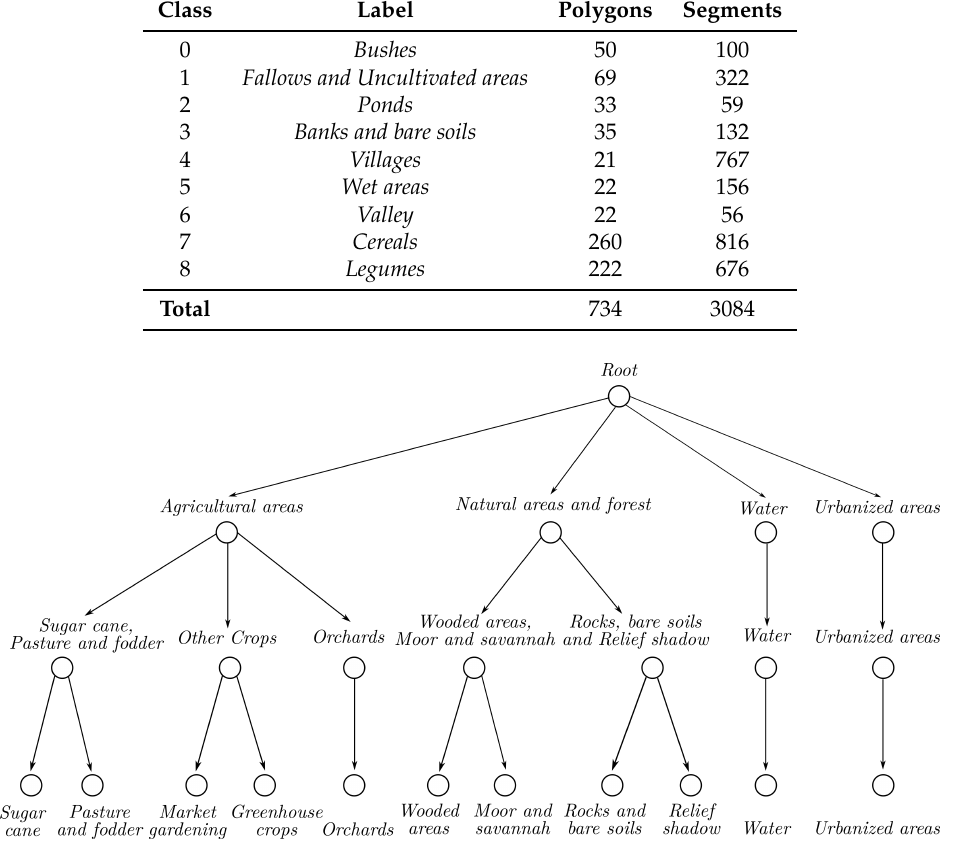
Figure 2. Overview of the taxonomy derived from the Reunion island land cover classes.